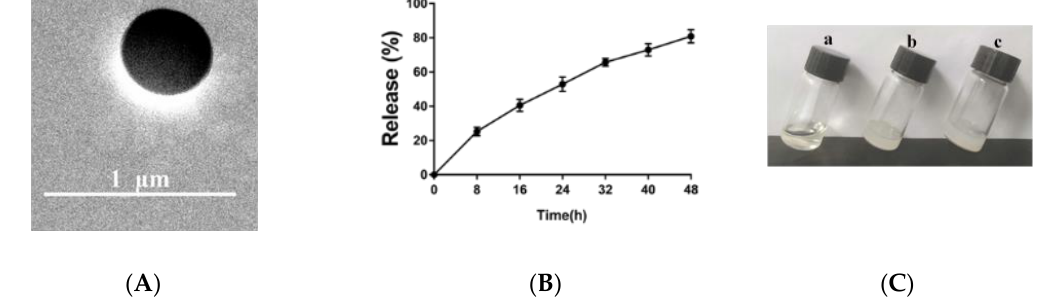
Table 1. Physicochemical characteristics of the nanoparticles.